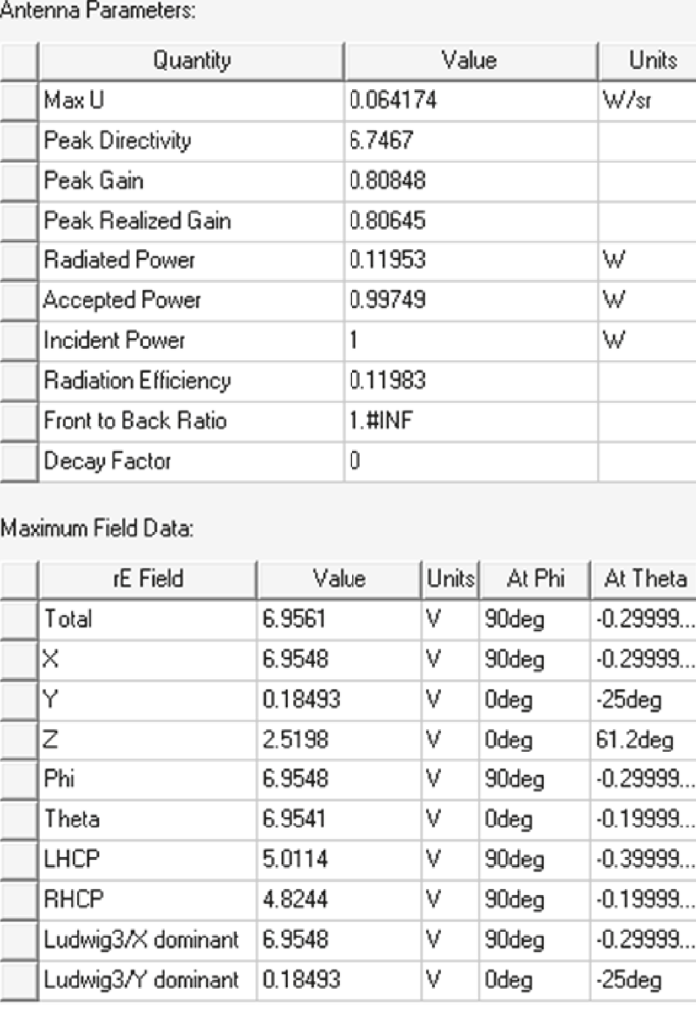
Figure 5: Antenna parameters obtained by